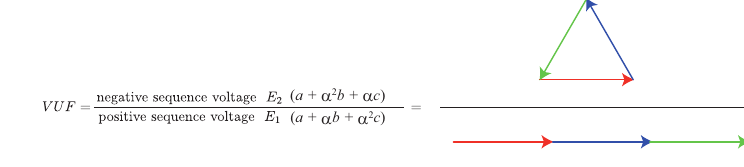
Figure 3. A graphical interpretation of VUF in the balanced